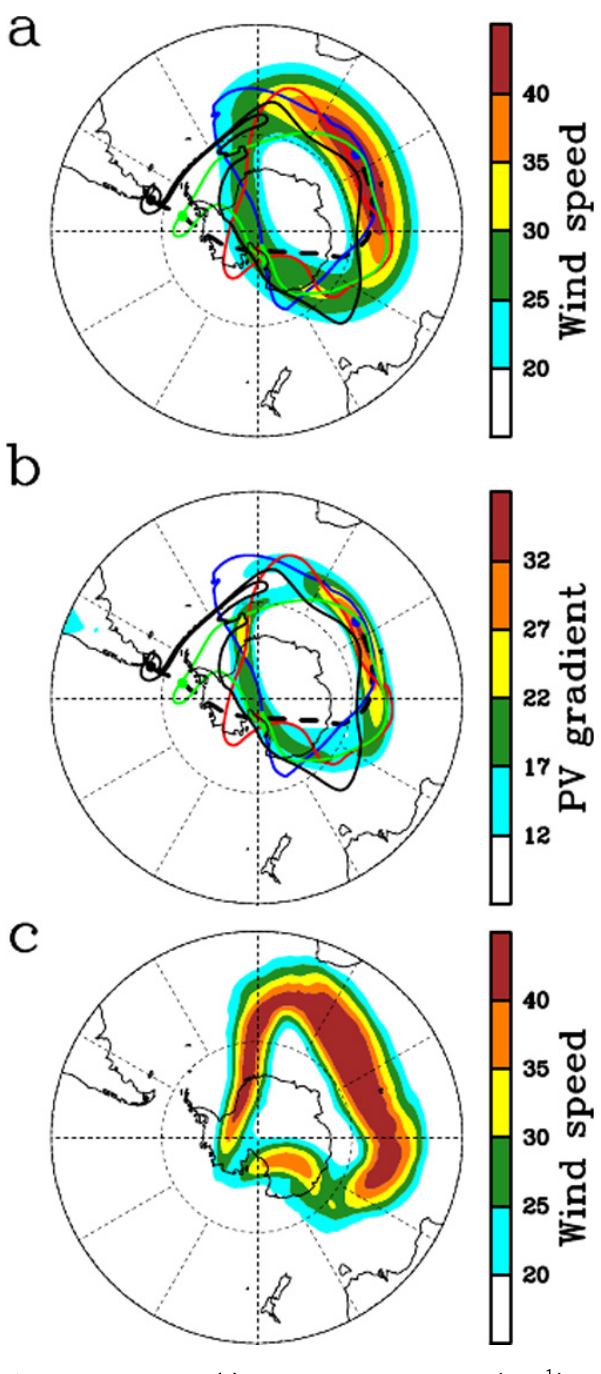
Fig. 6. Distributions of (a) the background wind speed (ms − 1 ) and (b) the background horizontal PV gradient fields from ECMWF at 500K level, averaged within the period between 19 and 25 Novem- ber 2005. The black-dashed curve represents the real isopycnic tra- jectory of the balloon observed between day 19 and day 25. The col- ored curves represent the PV contour with the magnitude of 28PVU from the CAS calculations on day 19 (blue), day 21 (red), day 23 (green) and day 25 (black). For each day, the location of the balloon is denoted by a dot using the same color. (c) Distribution of the wind field obtained on day